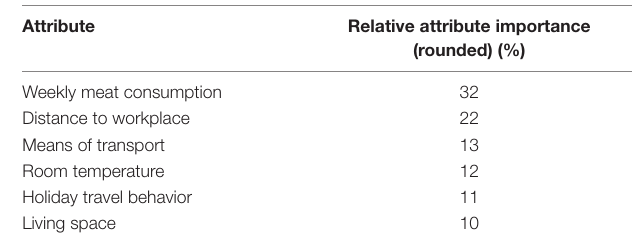
TaBle 4 | importance of attributes ordered by importance (relative importance values sum to